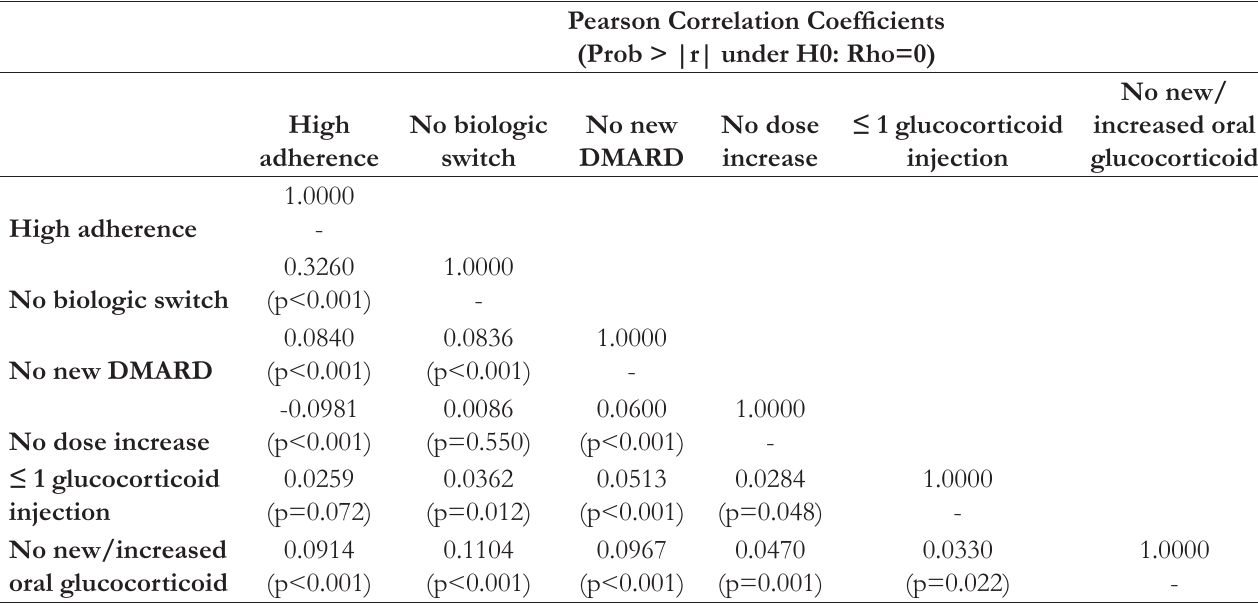
Table 4. Matrix of Pearson Correlation Coefficients Between Criteria of the Effectiveness